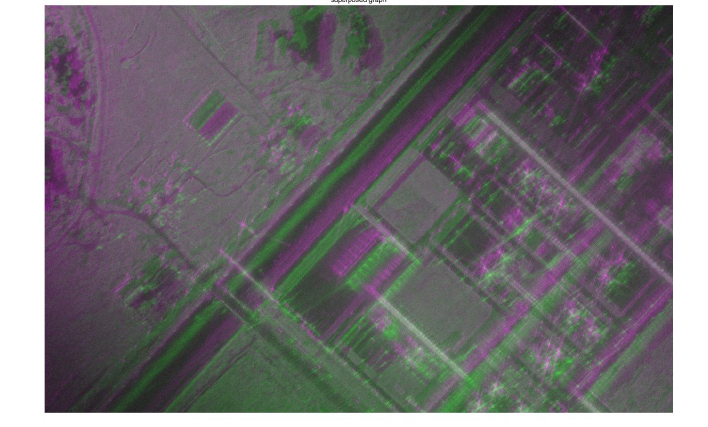
Figure 12. A superposed graph of two different sub-aperture images. Offset between two images is caused by height difference.